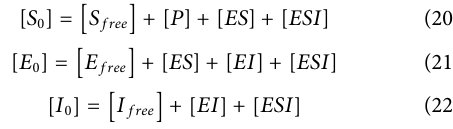
conserved total species input (S 0 , E 0 , or I 0 ); subtractive (negative) inputs are caused by the use of the species (for binding or product transformation) to generate other species (P, ES, EI, or ESI); fi nally, free variables (S free , E free , or I free ) are the resulting outputs of the adder blocks. The subtractive inputs always cause the ‘ use-it-and-lose-it ’ implicit negative-feedback loops in chemical reaction networks (Teo et al., 2015; Teo and